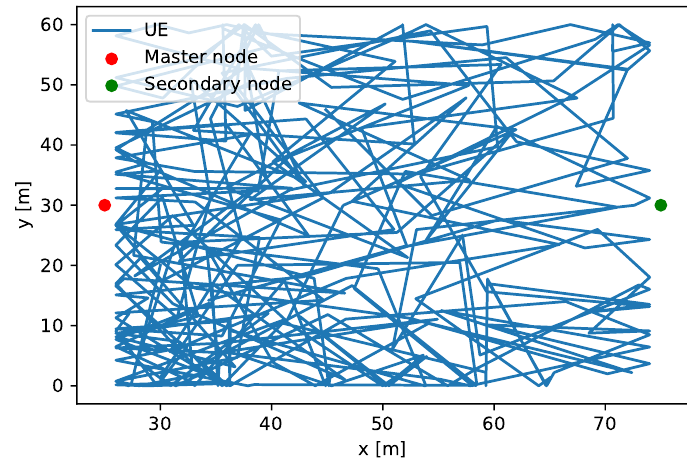
Figure 4. UE movement over the entire